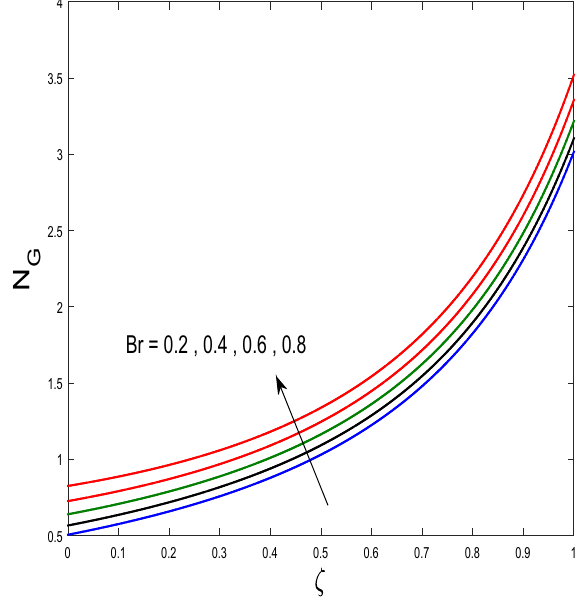
Figure 21. Plot of N G for Br .